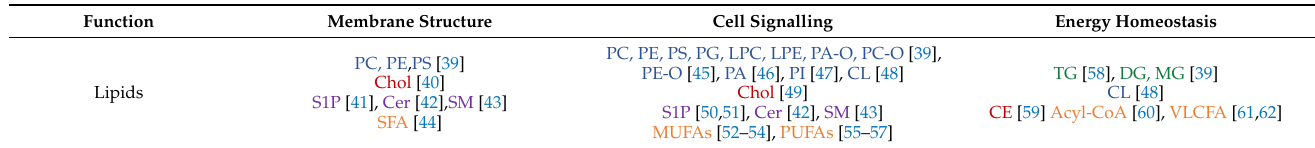
Table 1. Functional characteristics of lipid molecules and associated enzymes implicated in CRC. The diverse functions of lipids and associated enzymes implicated in CRC can be broadly categorized into three key processes: membrane structure, cell signalling, and energy